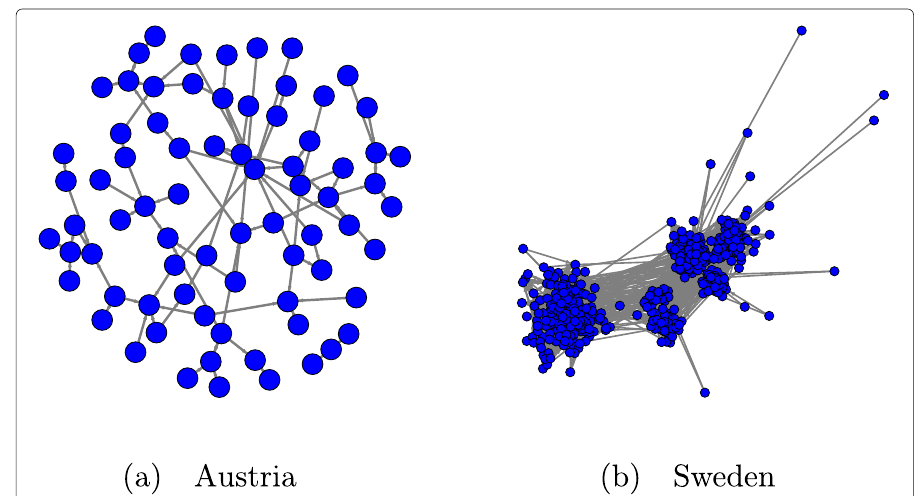
Fig. 1 Differences in Legislative Structure Between Countries. A side-by-side comparison of the legislative networks in ( a ) Austria and ( b ) Sweden, both from the same year (2002). This figure highlights the baseline structural differences between the networks which necessitate controlling for fixed effects at the country level